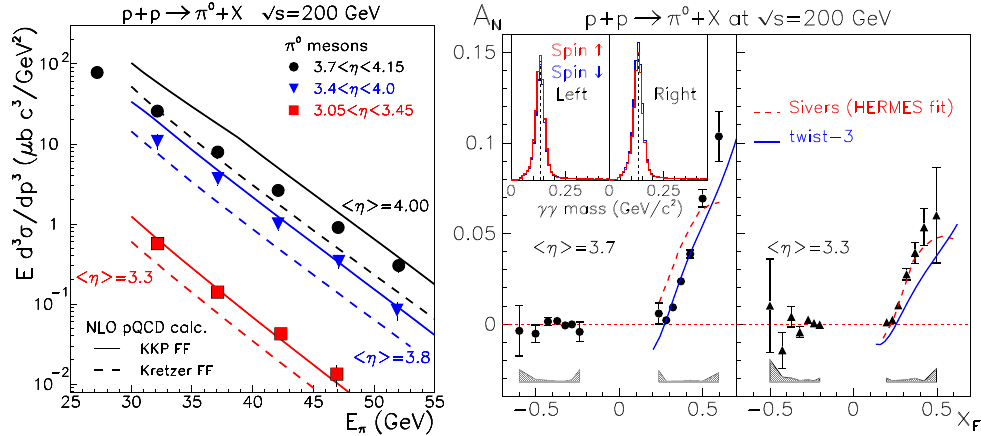
Figure 2. (Left) Cross sections for inclusive neutral pions produced at large x F [15] compared to NLO pQCD calculations. (Right) Analyzing power for the inclusive production of neutral pions at large x F [16], in comparison to calculations described in the